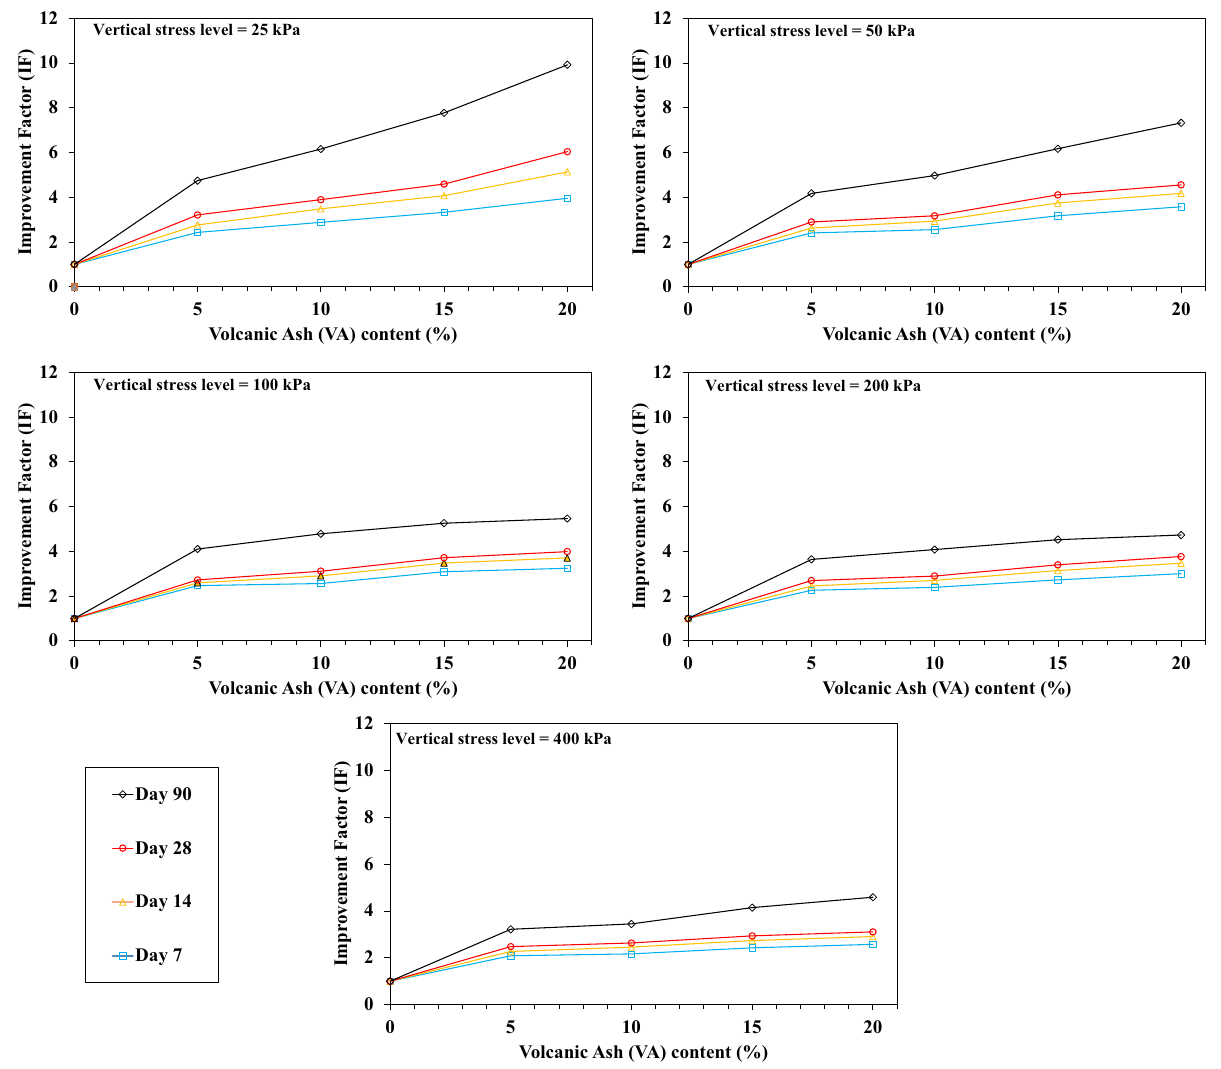
Figure 12. Influence of the volcanic ash (VA) content on the improvement factor (IF) for saturated